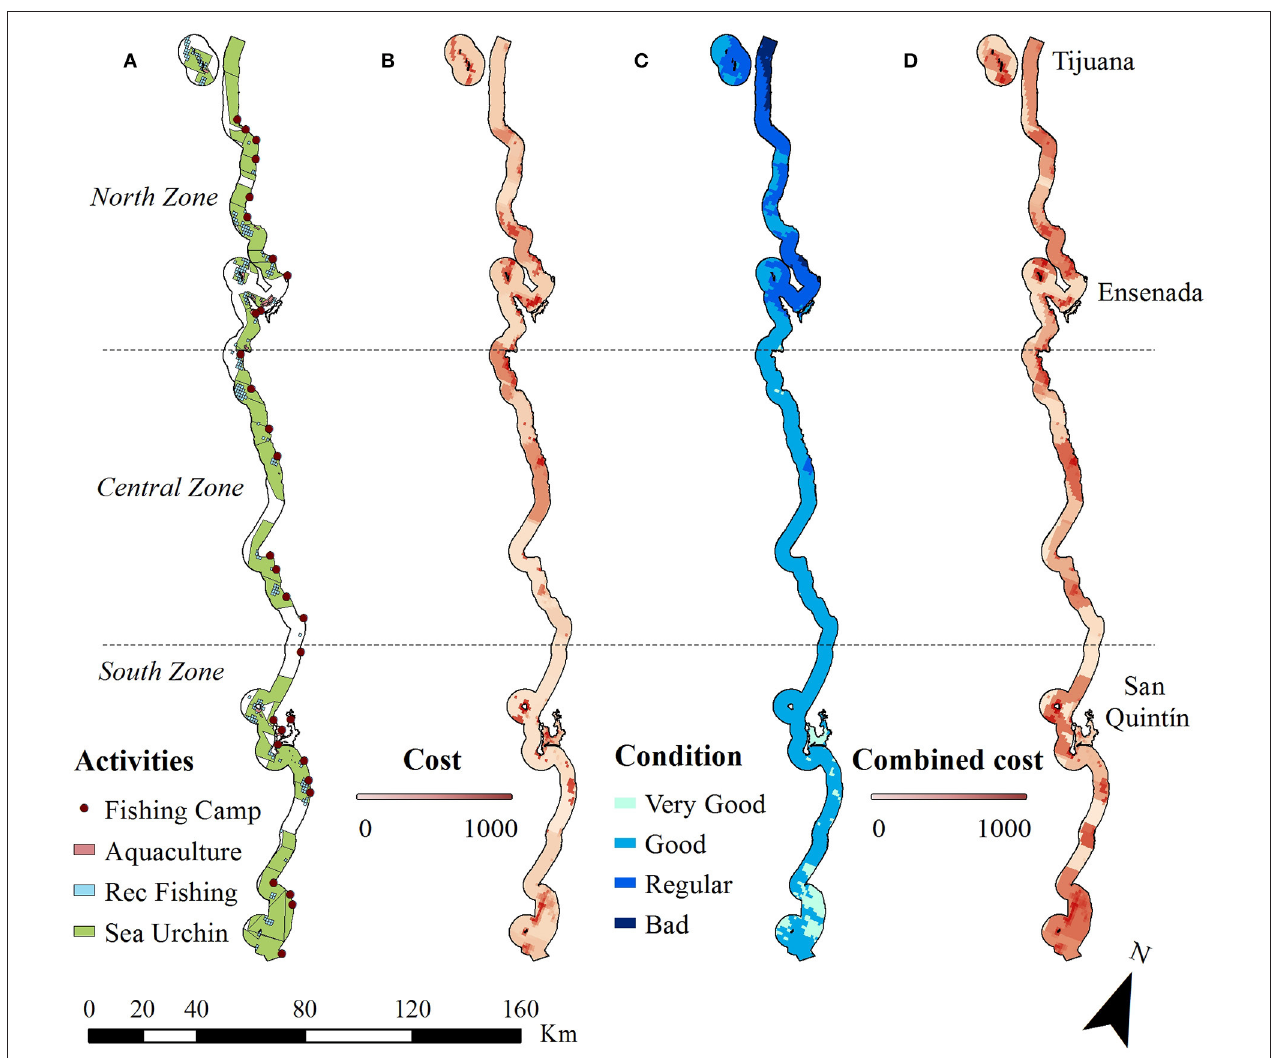
FIGURE 3 | Distribution of (from left to right) (A) socio-economic activities of commercial fishing (fishing camps and red sea urchin polygons), recreational fishing, and aquaculture activity, (B) combined opportunity cost layer for the three activities, (C) habitat condition classification, and (D) combined opportunity and enforcement cost layer for the MPRC1, Baja California, Mexico.